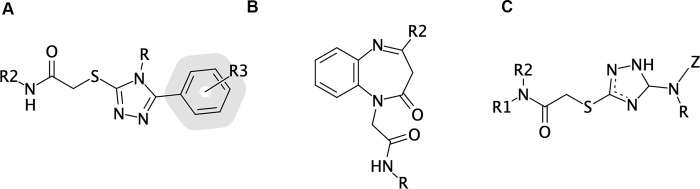
Generic chemical formula of the 3 patented families.(A) Family I; (B) Family II, (C) Family III.